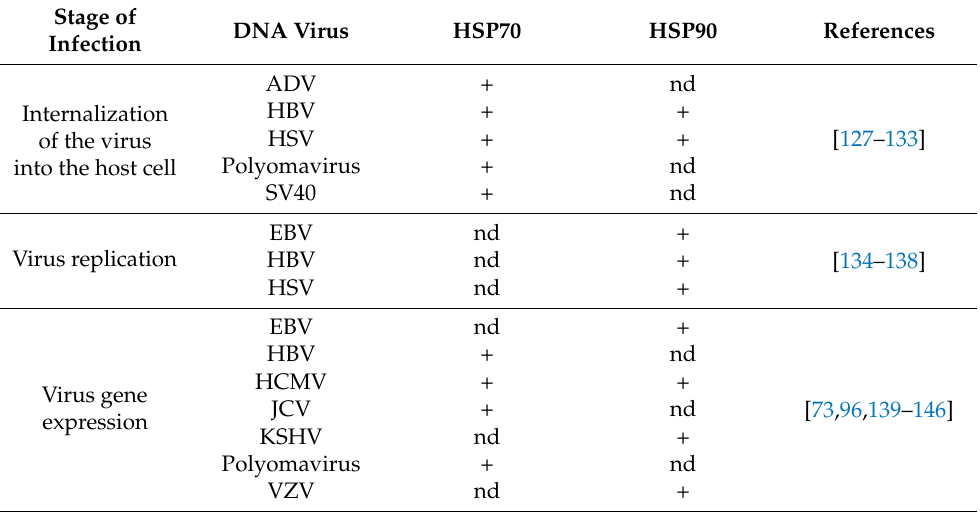
Table 4. Utilization of HSP70 and HSP90 of host cells by DNA viruses at particular stages of infection. Stage of DNA Virus HSP70 Infection